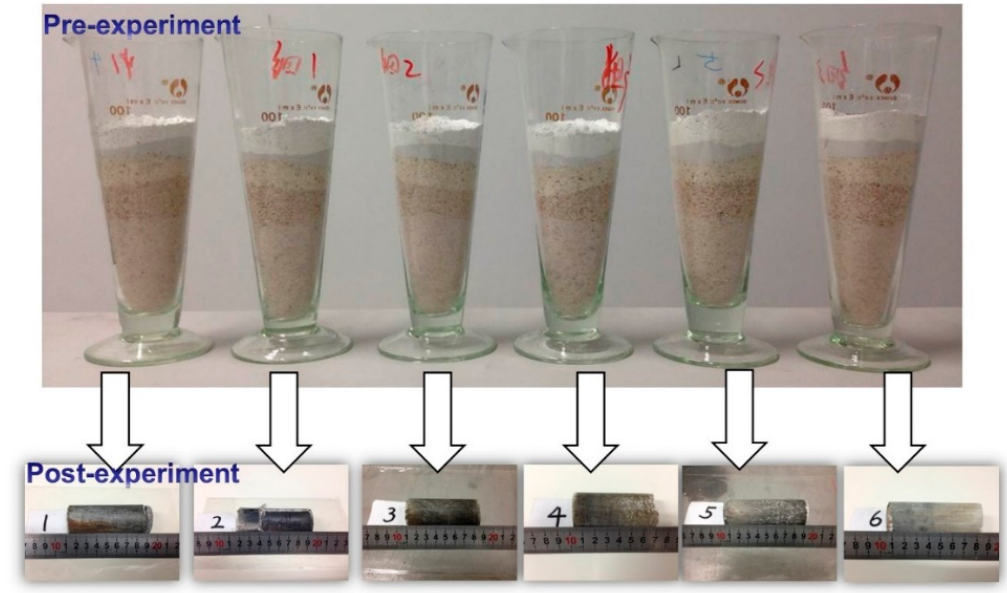
Figure 2. Synthetic core samples made by the physical experiment.